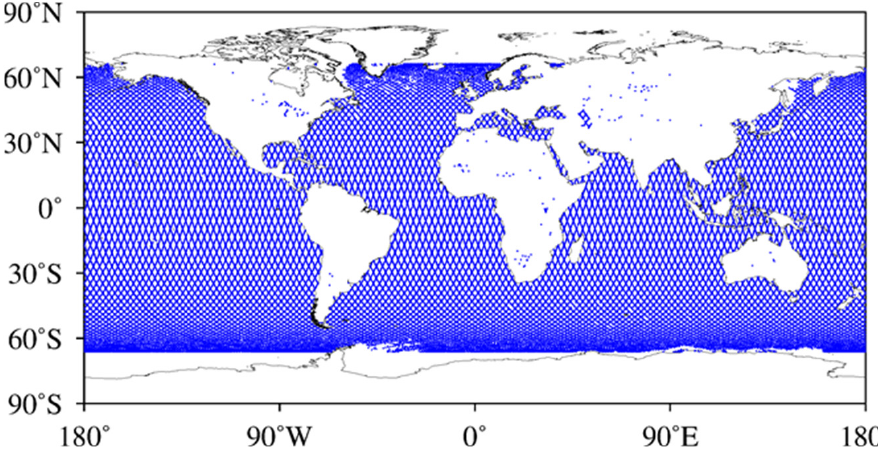
Figure 1. Trajectory of Jason2 satellite for its repeat